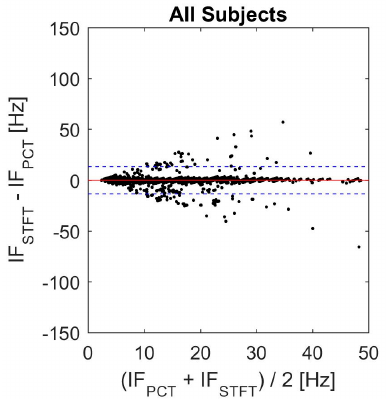
Figure 11. Bland-Altman plot for PCT and STFT IF. The solid line represents the mean (bias) value of differences between instantaneous frequencies. The dashed lines show the 95% confidence interval. Table 6. Statistical analysis results based on the Bland-Altman method (LOV: level of agreement).